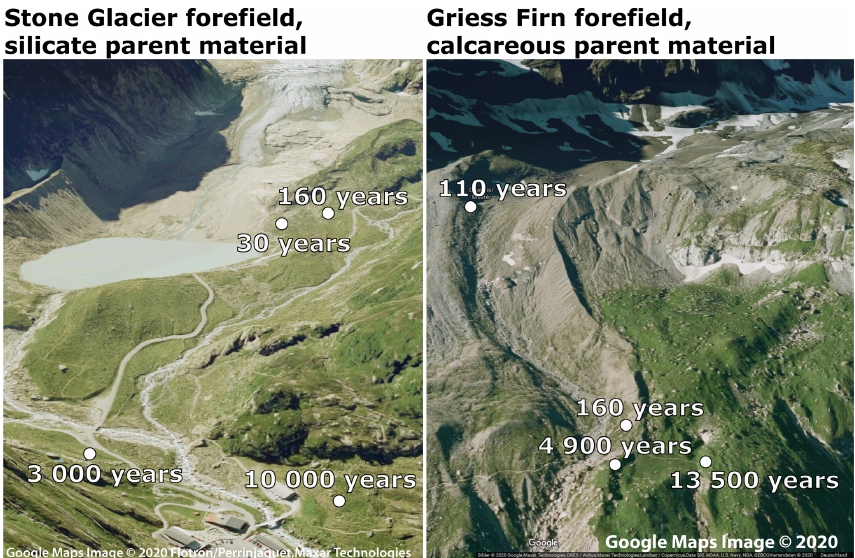
Figure 1. Glacier forefield and location of the four selected moraines of the silicate parent material (S-PM, left; Google, 2020a) and the calcareous parent material (C-PM, right; Google,